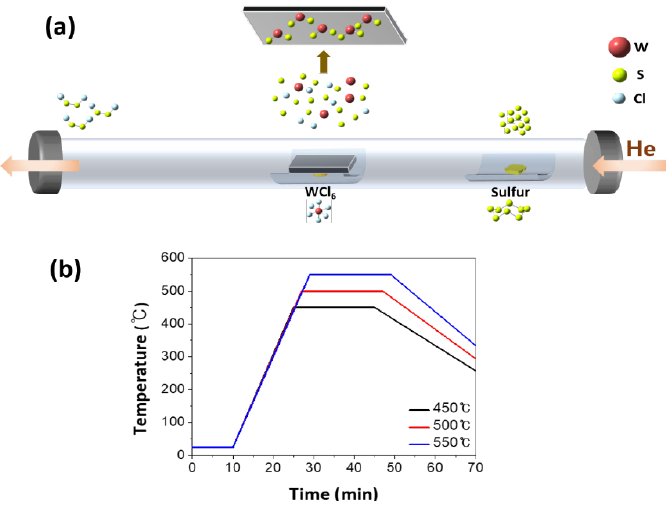
Figure 1. ( a ) Scheme of the chemical deposition process of the WS 2 nanosheets and ( b ) temperature profile during the growth process.